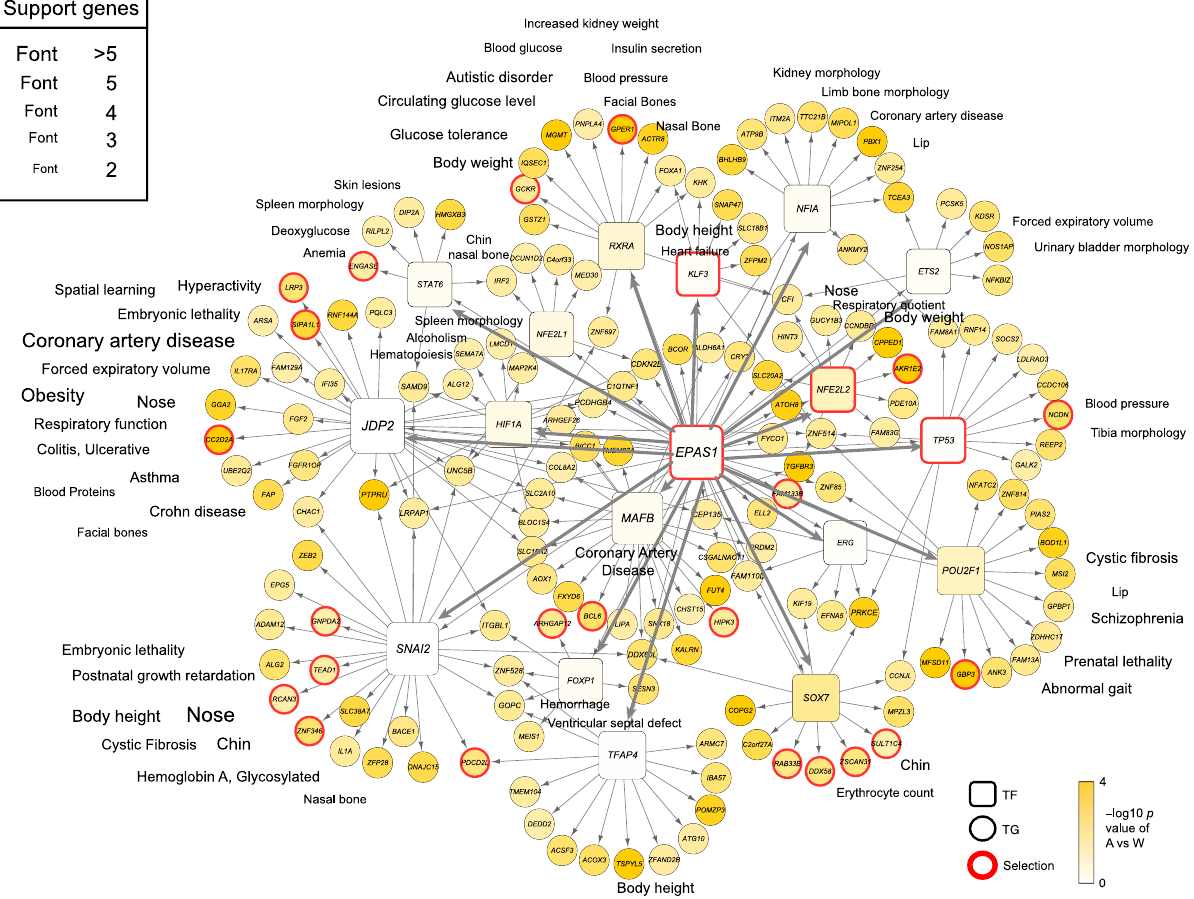
Fig. 5 EPAS1 -oriented regulatory network associates various phenotypes. The EPAS1 -oriented network is extracted from vPECA by selecting genes satisfying the conditions: the 1st and 2nd neighbor downstream of EPAS1 , differentially expressed genes and enhancers between 0 – 6 h and 1 – 3 day (FDR < 0.05) and differentially expressed genes and enhancers between A and W ( p -value < 0.05). Rectangles refer to TFs and circles are TGs. Genes with a red border are those with reported selection signals in Tibetan. Colors denote the − log 10 ( p -value) of t -test of gene expression between A and W. Source data are provided as a source data fi